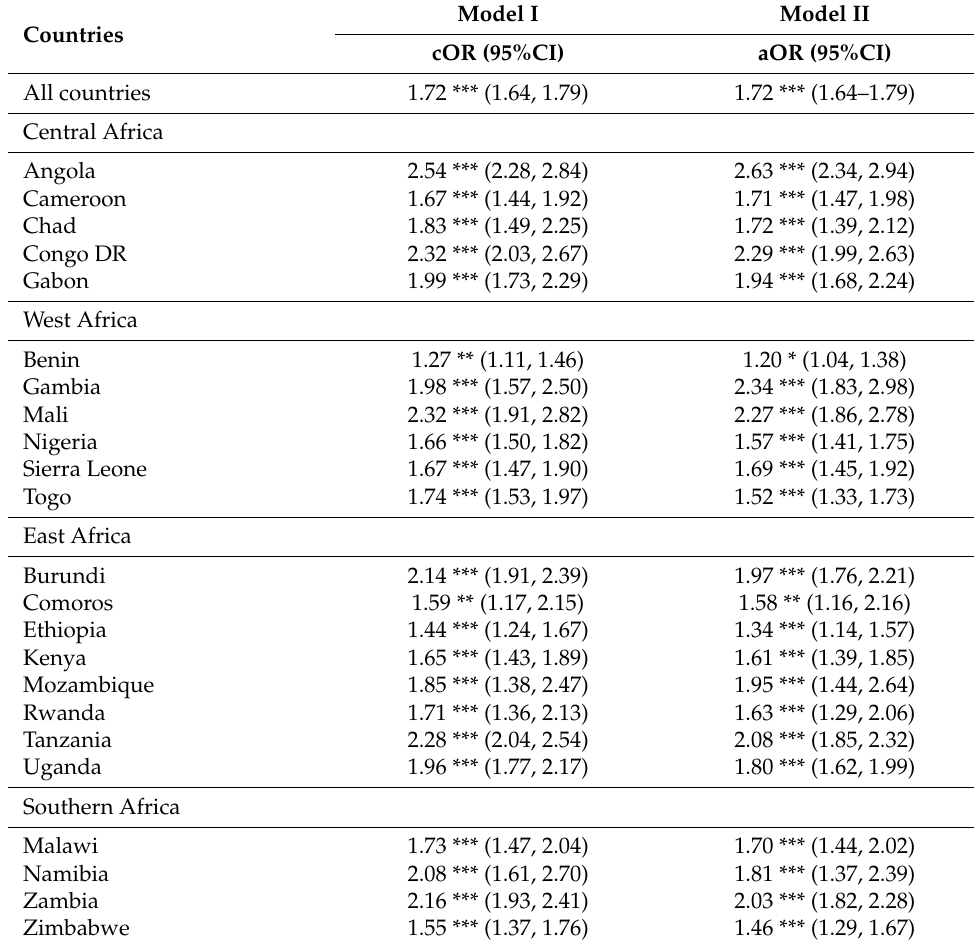
Table 3. Logistic regression on the association between attitude towards IPV and past-year experience of IPV in sub-Saharan